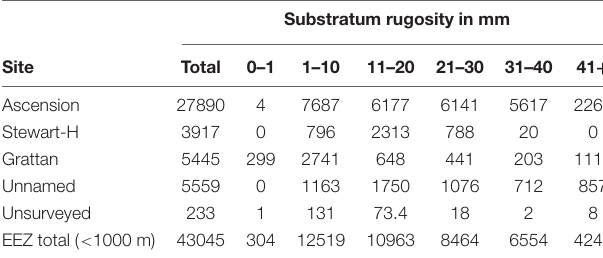
TABLE 6 | Zoobenthic carbon storage by rugosity and area, in